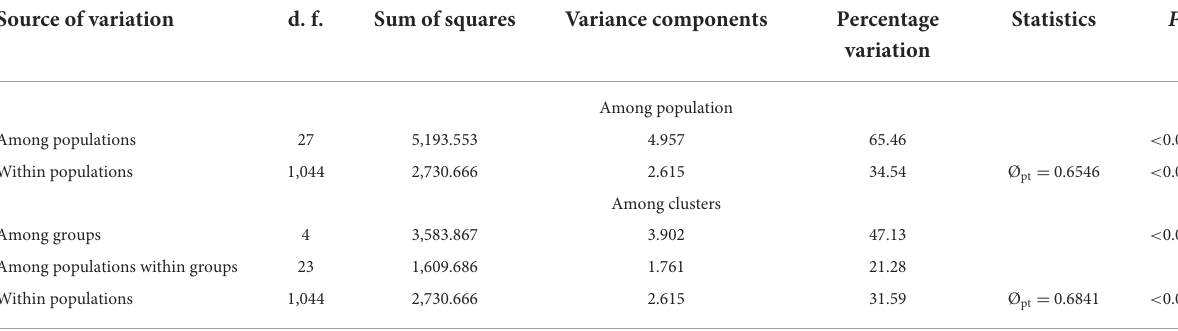
TABLE 3 AMOVA results based on 23 neutral loci for the 28 population of Z. latifolia across China. Source of variation